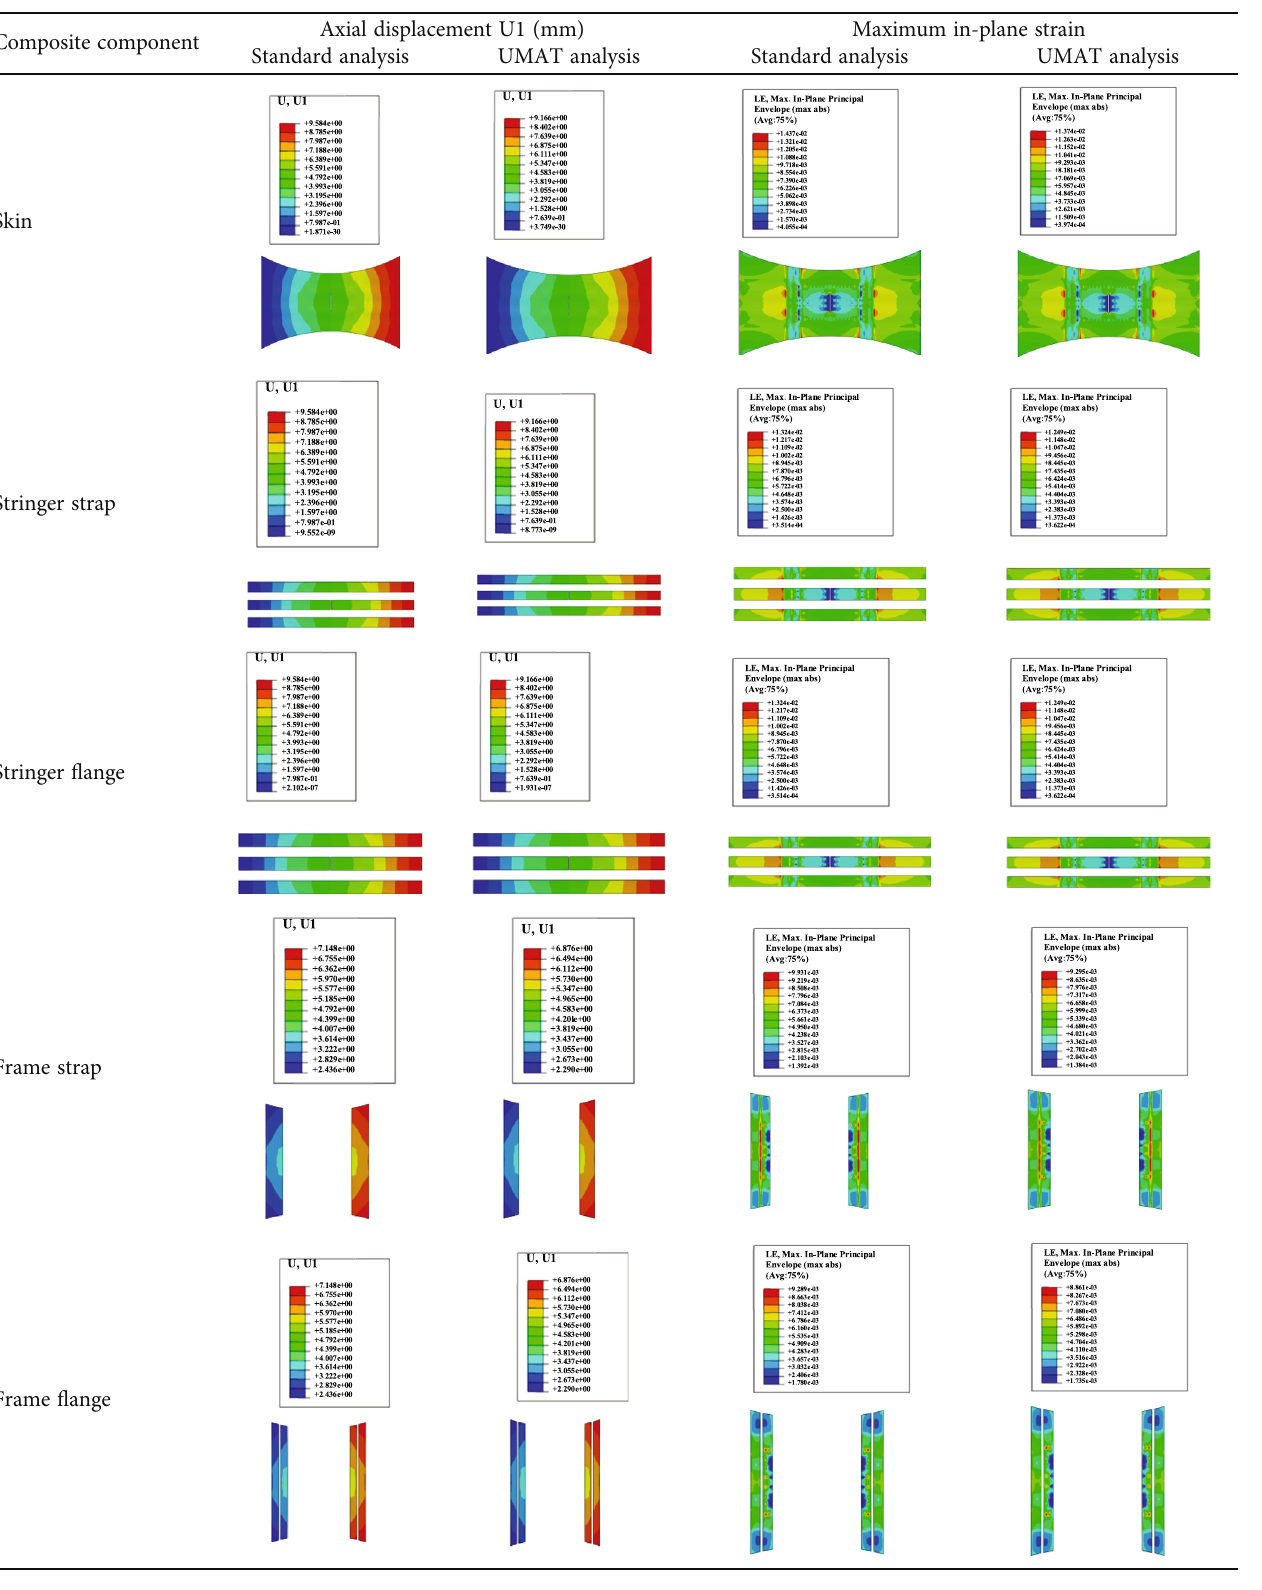
Table 7: Comparison between standard analysis and UMAT analysis in values of axial displacement and maximum in-plane strain in composite components at end of the load